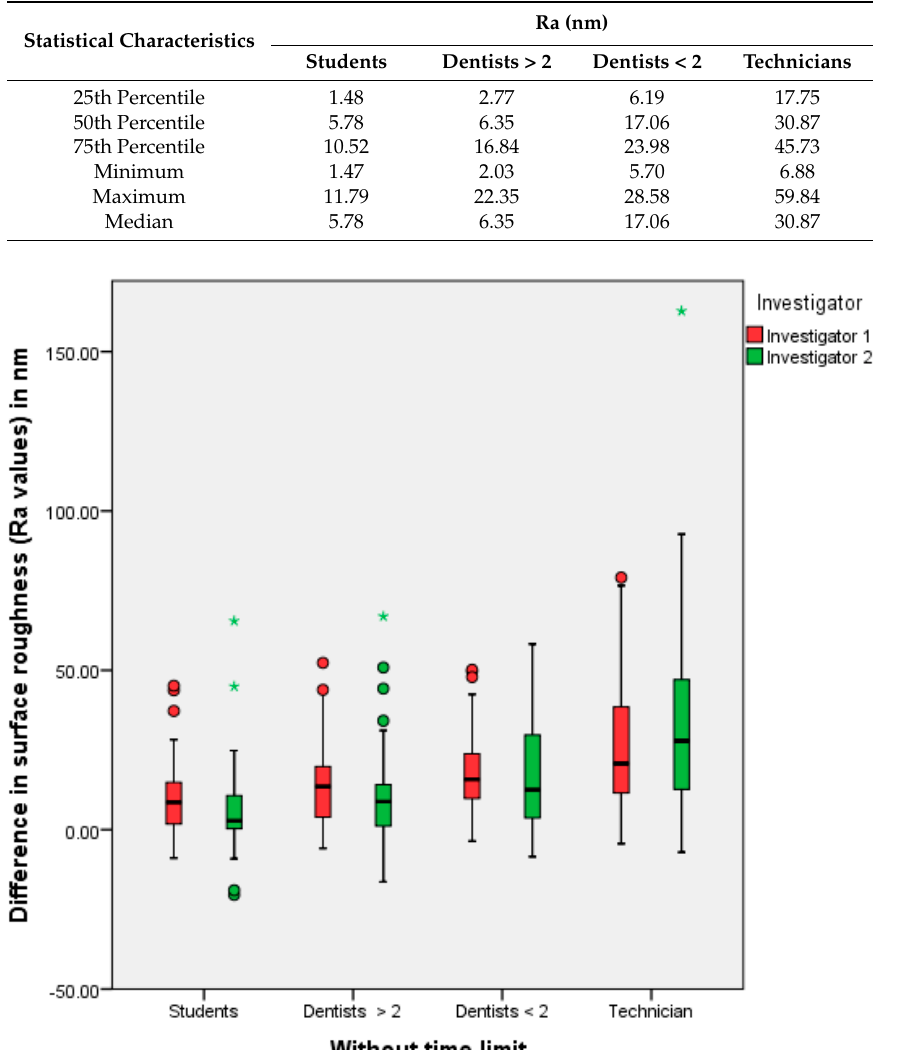
Table 2. Descriptive analysis of the Ra values (nm) of investigator 2 and trial one achieved by the specific practitioner groups.